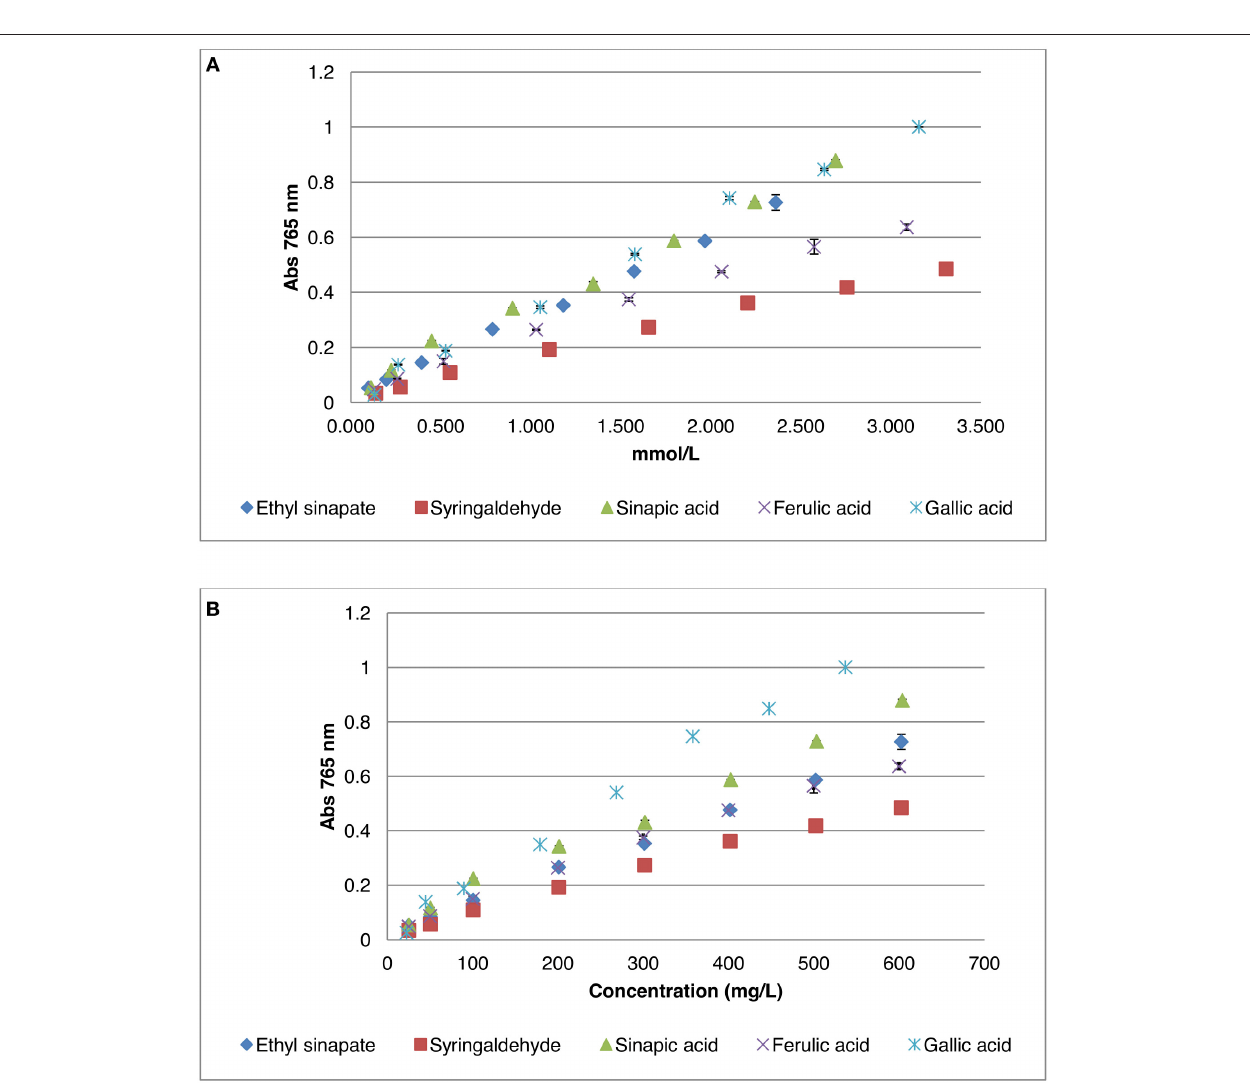
FIGURE 2 | Calibration curves of different phenolic compounds by Folin-Ciocalteu method. (A) Absorbance as a function of the concentration in mmol/L; (B) Absorbance as a function of the concentration in mg/L.